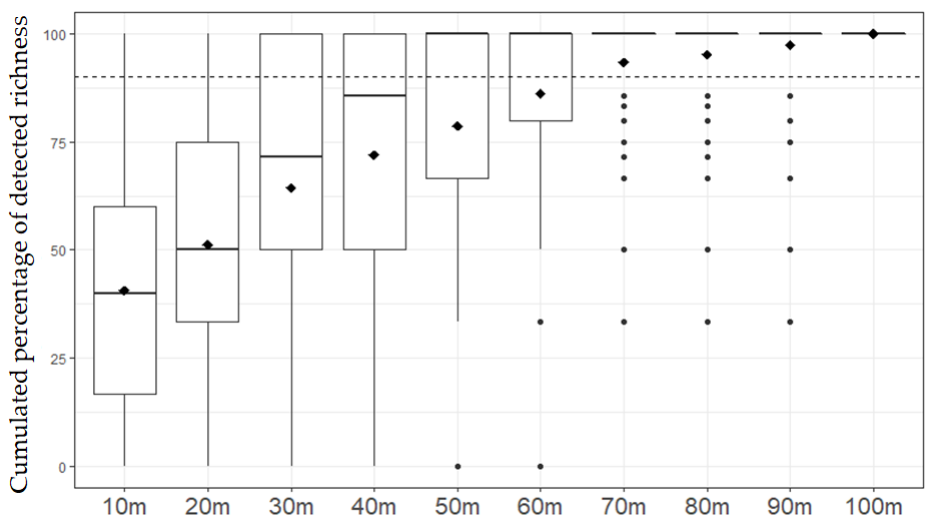
Figure 8. Cumulated percentage of detected richness depending on number of 10 m plots scouted for exuviae along each transect ( n = 98 transects). Box plots indicate median, range, and first and third quartiles. Points indicate outliers. Black diamonds indicate the mean of each section. Dashed line indicates the 90% threshold.